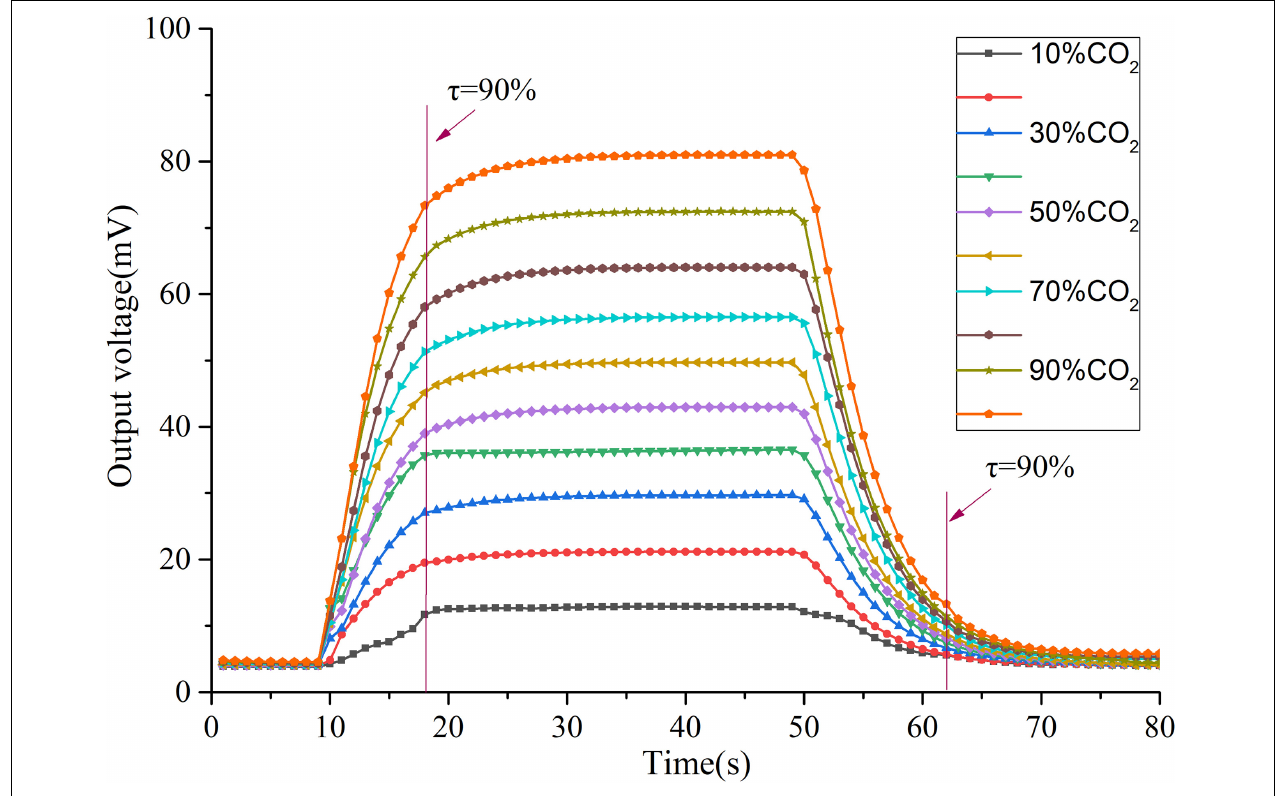
FIGURE 10 | Response and recovery curve of continuous measurement.